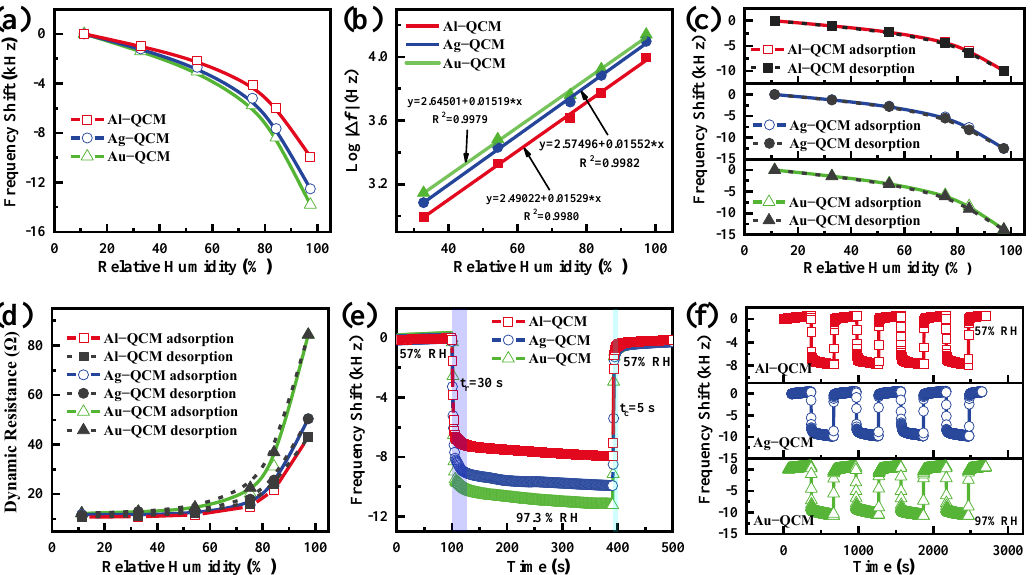
Figure 4. ( a ) The sensitivity, ( b ) logarithmic fitting curve of log| ∆ f| vs. RH, ( c ) humidity hysteresis, ( d ) dynamic resistance, ( e ) response/recovery time, and ( f ) repeatability of the Au-QCM, Ag-QCM, and